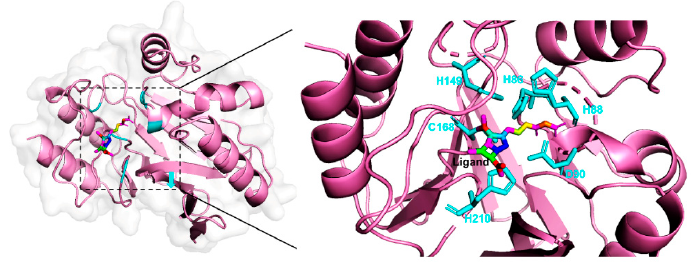
Figure 5. View of predicting effects of residue mutation on the catalytic efficiency of the lactam hydrolysis reaction (Beta-Lactamase, PDB:1BC2). Regions of mutated sites that decrease catalytic efficiency are highlighted in cyan on the cartoon. Ligand is shown as sticks in the rainbow. Table 3. Kcat/Km parameters of wild-type enzymes and their mutants.